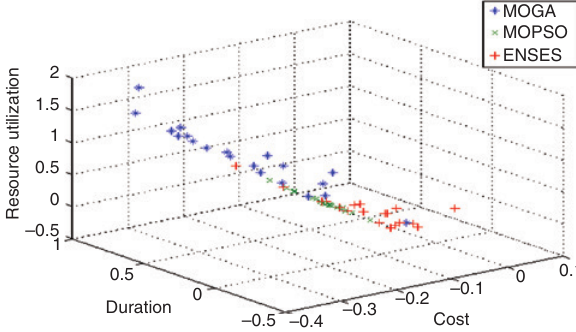
Figure 5: MOGA, MOPSO, and ENSES Resource Optimization Pareto